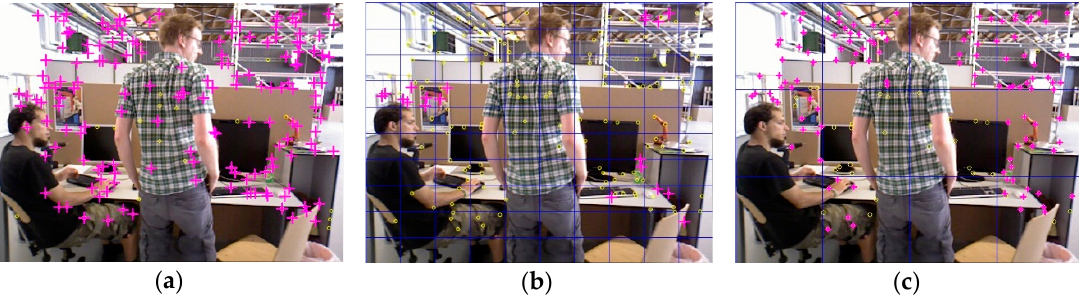
Figure 4. Samples in TUM sequence fr3_walking_rpy. As seen in Figure 3, static points are marked with green circles while others are marked with yellow circles. ( a ) Recognition results by RANSAC. ( b ) Recognition results by ARSAC. ( c ) Recognition results by DLRSAC.